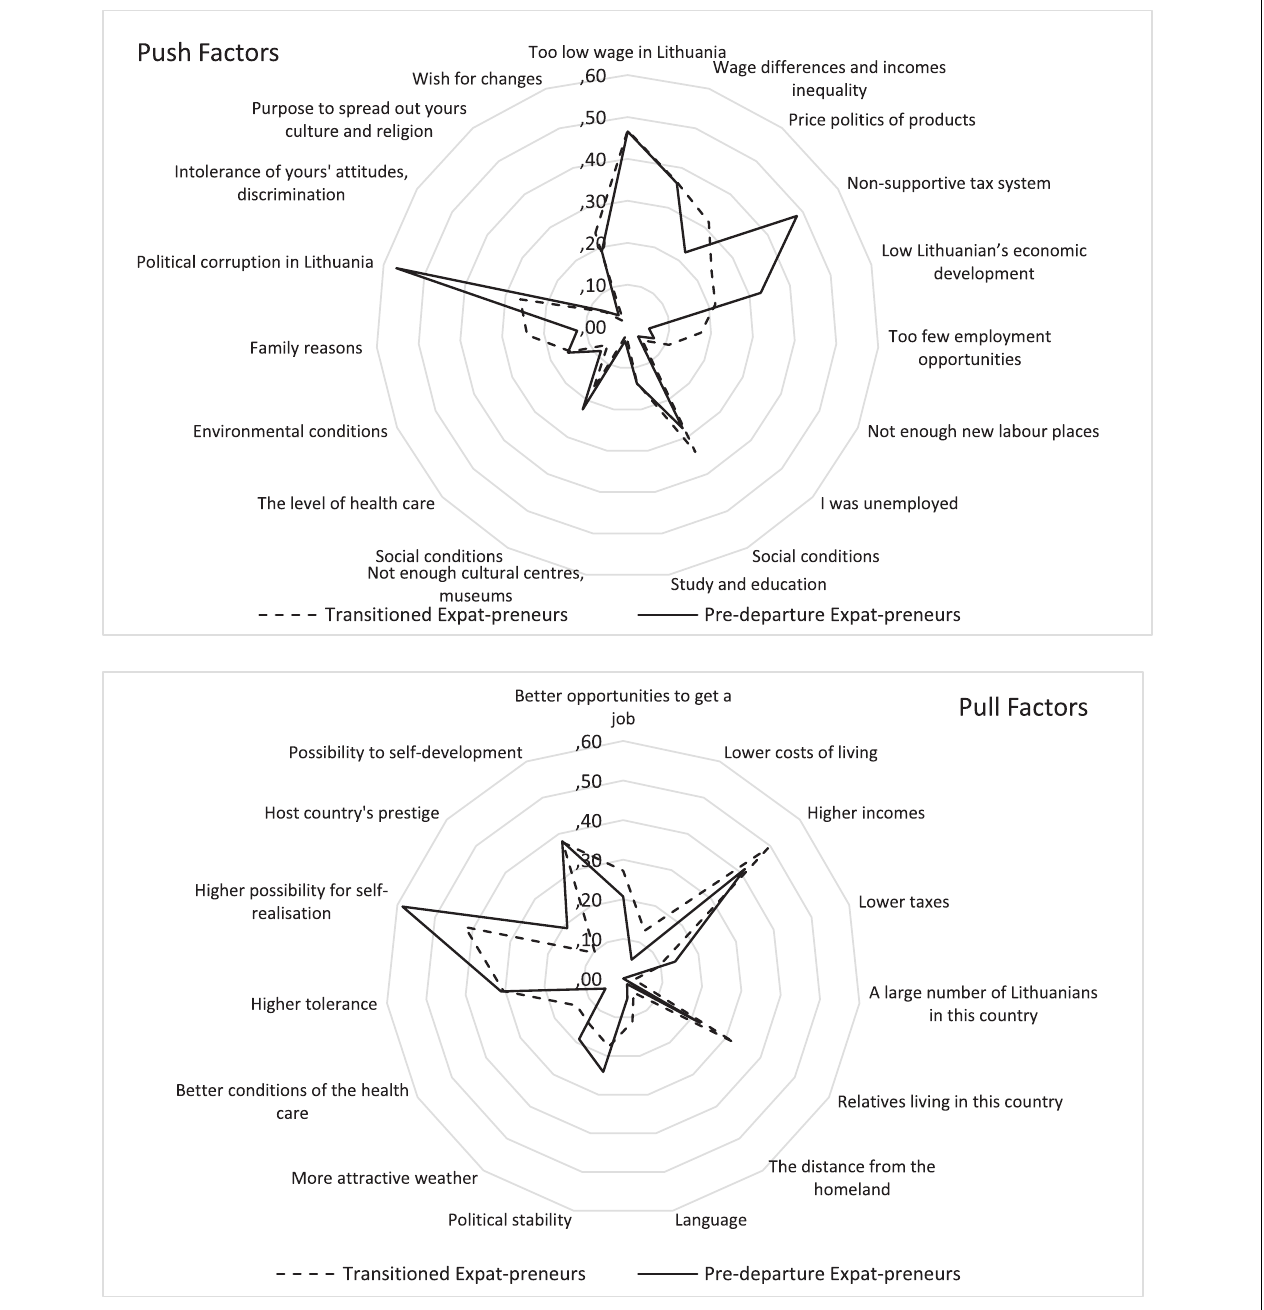
FIGURE 2 | Profiles of pre-departure and transitioned expat-preneurs according to expatriation factors.